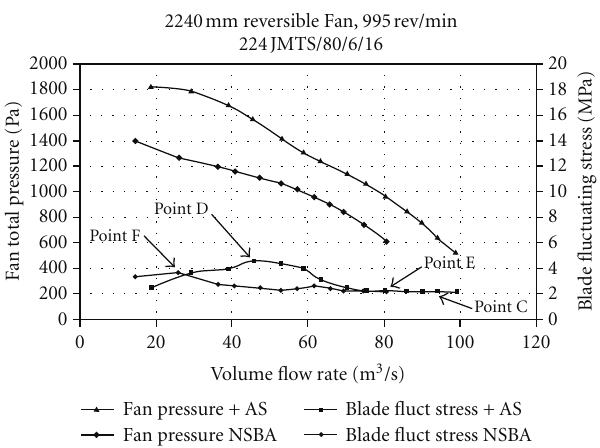
Figure 4: Stall characteristics of the test fan with a nonstalling blade stagger